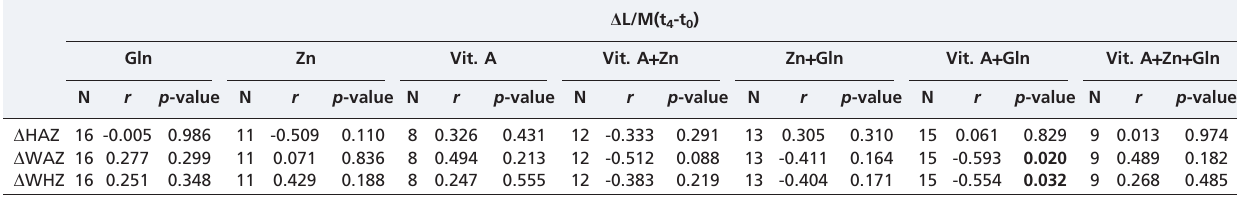
Table 3 - Pearson correlations between the change in the lactulose:mannitol (L/M) ratio (an intestinal permeability indicator) during the initial 4 months of nutritional supplementation and D HAZ* (t 4 -t 0 ), D WAZ* (t 4 -t 0 ) and D WHZ* (t 4 -t 0 ) according to the experimental nutrition groups.